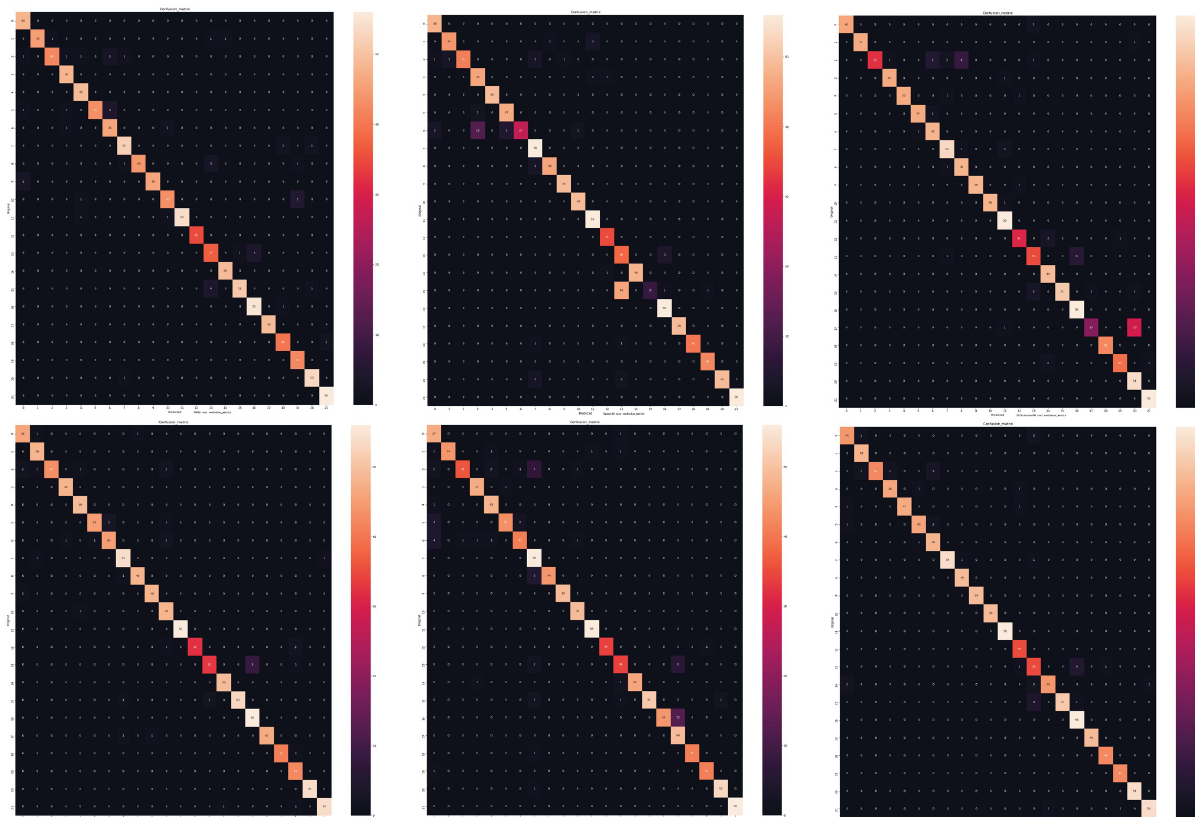
Fig 12. Confusion matrix diagram: Where the horizontal axis of the confusion matrix is the real type and the vertical axis is the prediction type. On the first line is the confusion matrix for VGG16 [51], ResNet50 [38], and EfficientNetB0 [52] networks, and on the second line is the confusion matrix for E-A-VGG16 and E-A-ResNet50, E-A-EfficientNetB0 networks.